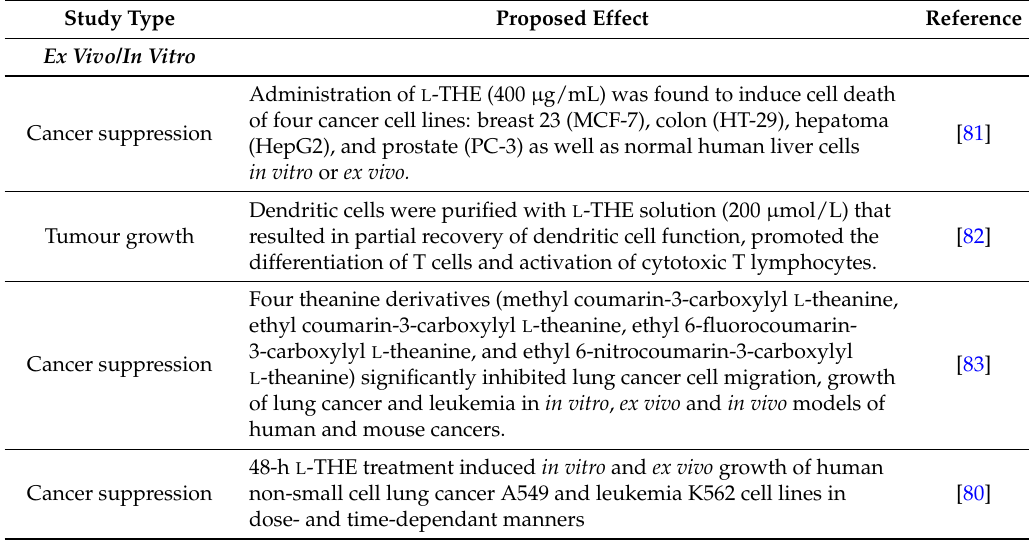
Table 4. The effect of L -THE on cancer